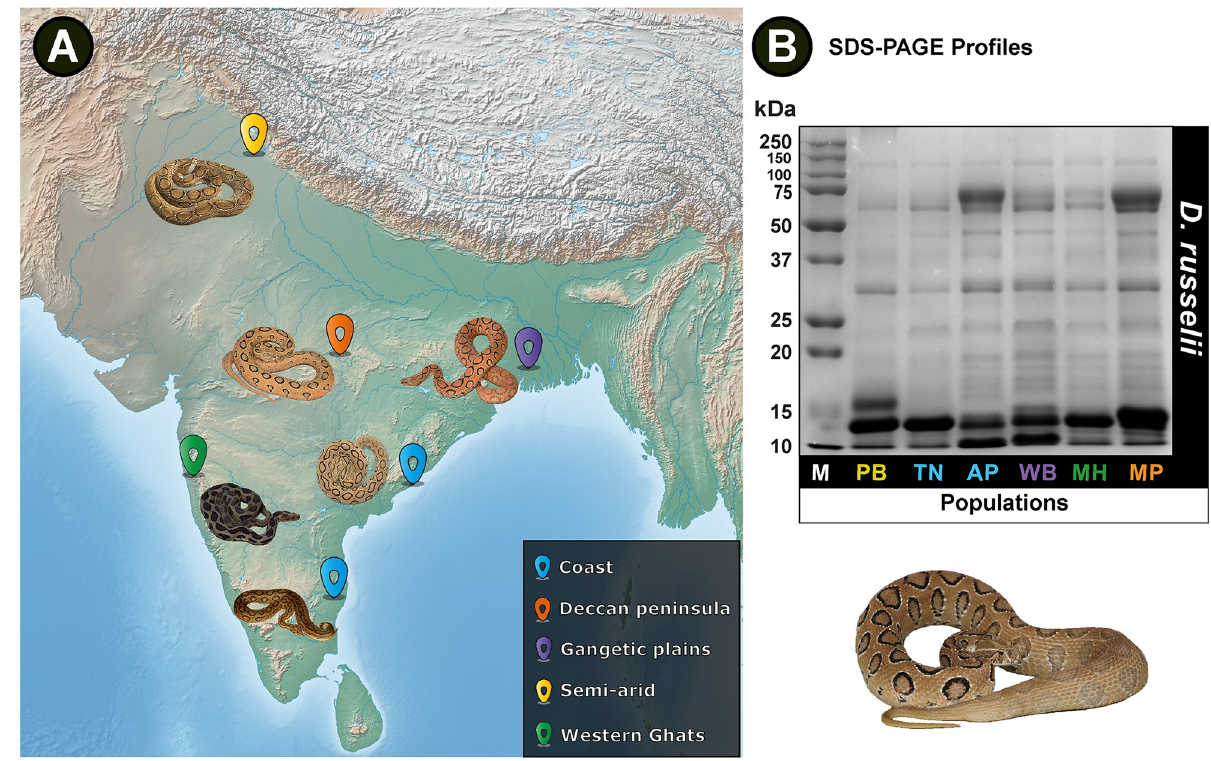
Fig 1. Map of India, prepared with QGIS 3.8.2 [35], depicts (A) sampling locations and (B) SDS-PAGE profiles of D . russelii venoms. M: Protein marker (units in kDa); PB: Punjab; TN: Tamil Nadu; AP: Andhra Pradesh; WB: West Bengal; MH: Maharashtra; MP: Madhya Pradesh.